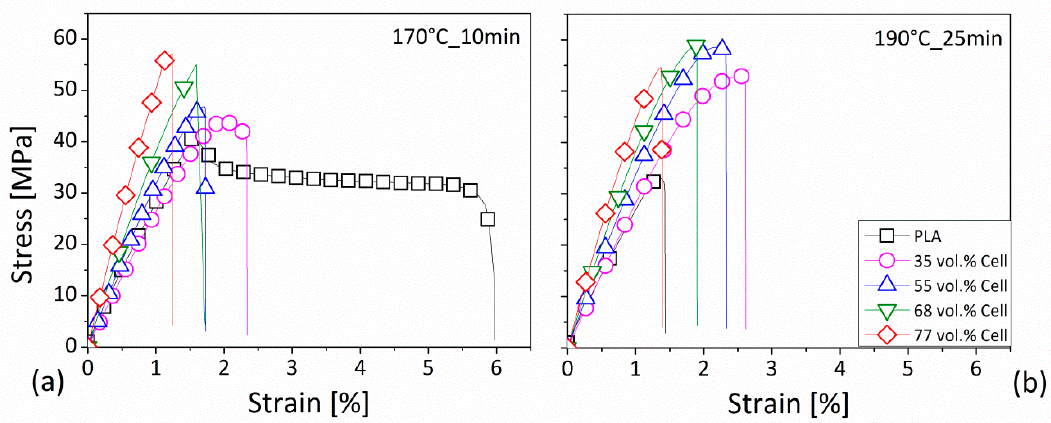
Figure 9. Examples of the stress–strain curves for the PLA-based compounds processed at: ( a ) 170 °C for 10 min; ( b ) 190 °C for 25 min. Legend in Figure 9a as in Figure 9b.